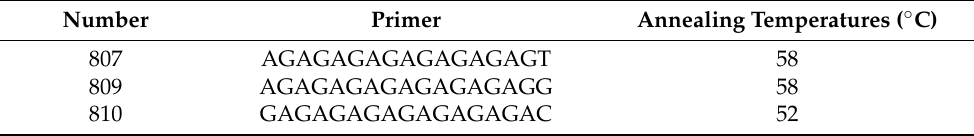
Table 3. Details of 9 primers used in